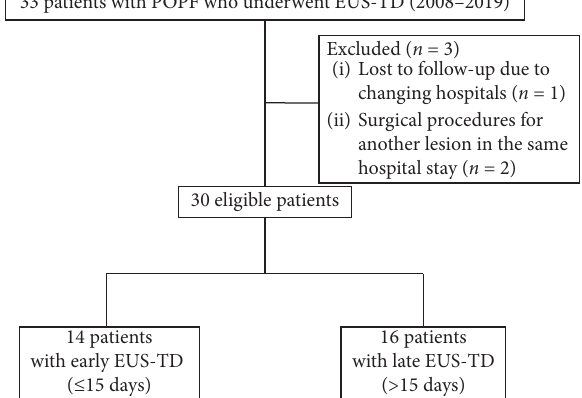
Figure 2: Flowchart of enrolled study patients. POPF, postoper- ative pancreatic fistula; EUS-TD, endoscopic ultrasound-guided transluminal